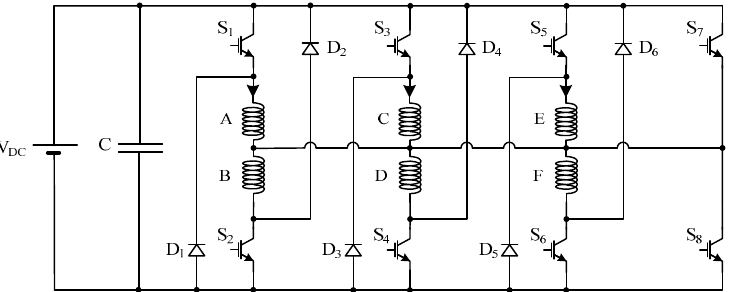
Figure 34. Fault-tolerant topology proposed by [100], combining multi-phase of SRM and two midpoint switches.